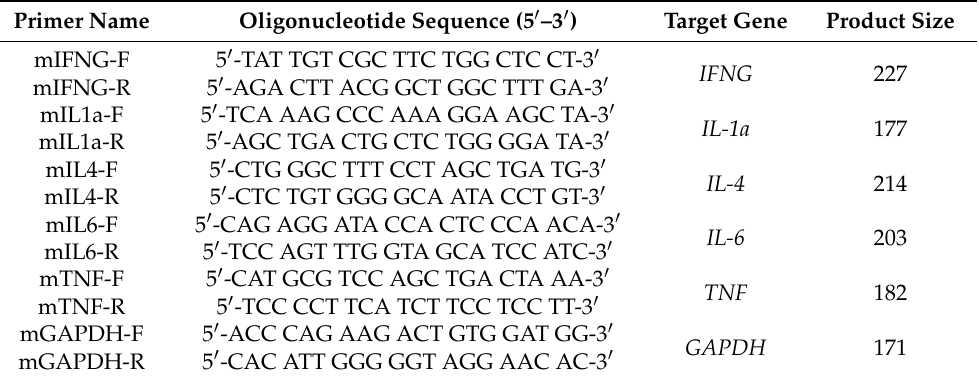
Table 2. PCR and oligonucleotide sequences of primers targeting cytokine genes used in this